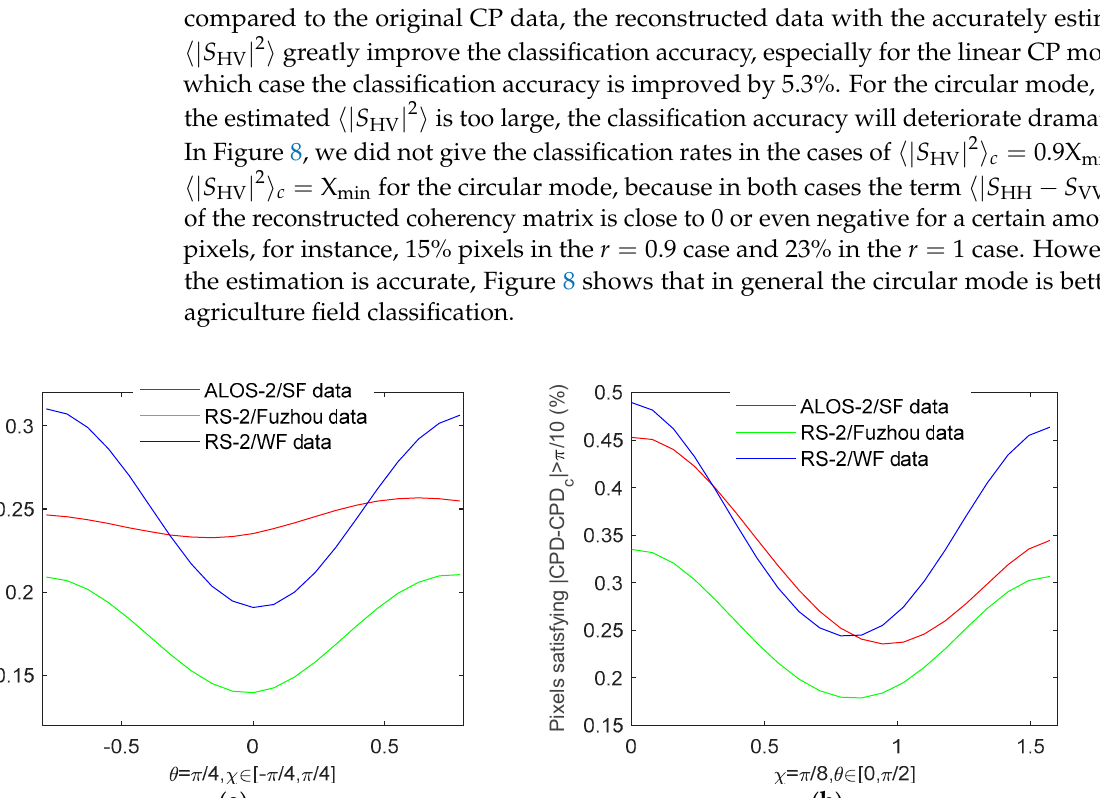
original 3 × 3 FP covariance matrix data. The reconstructed 〈|(cid:1845) (cid:2892)(cid:2906) | (cid:2870) 〉 is assumed to be m i (cid:1870)X (cid:1870) ∈ (cid:4670)0.1 1(cid:4671) , where X (cid:2923)(cid:2919)(cid:2924) with (cid:2923)(cid:2919)(cid:2924) is the upper bound for the cross-pol term in estima- 1 X 0 .